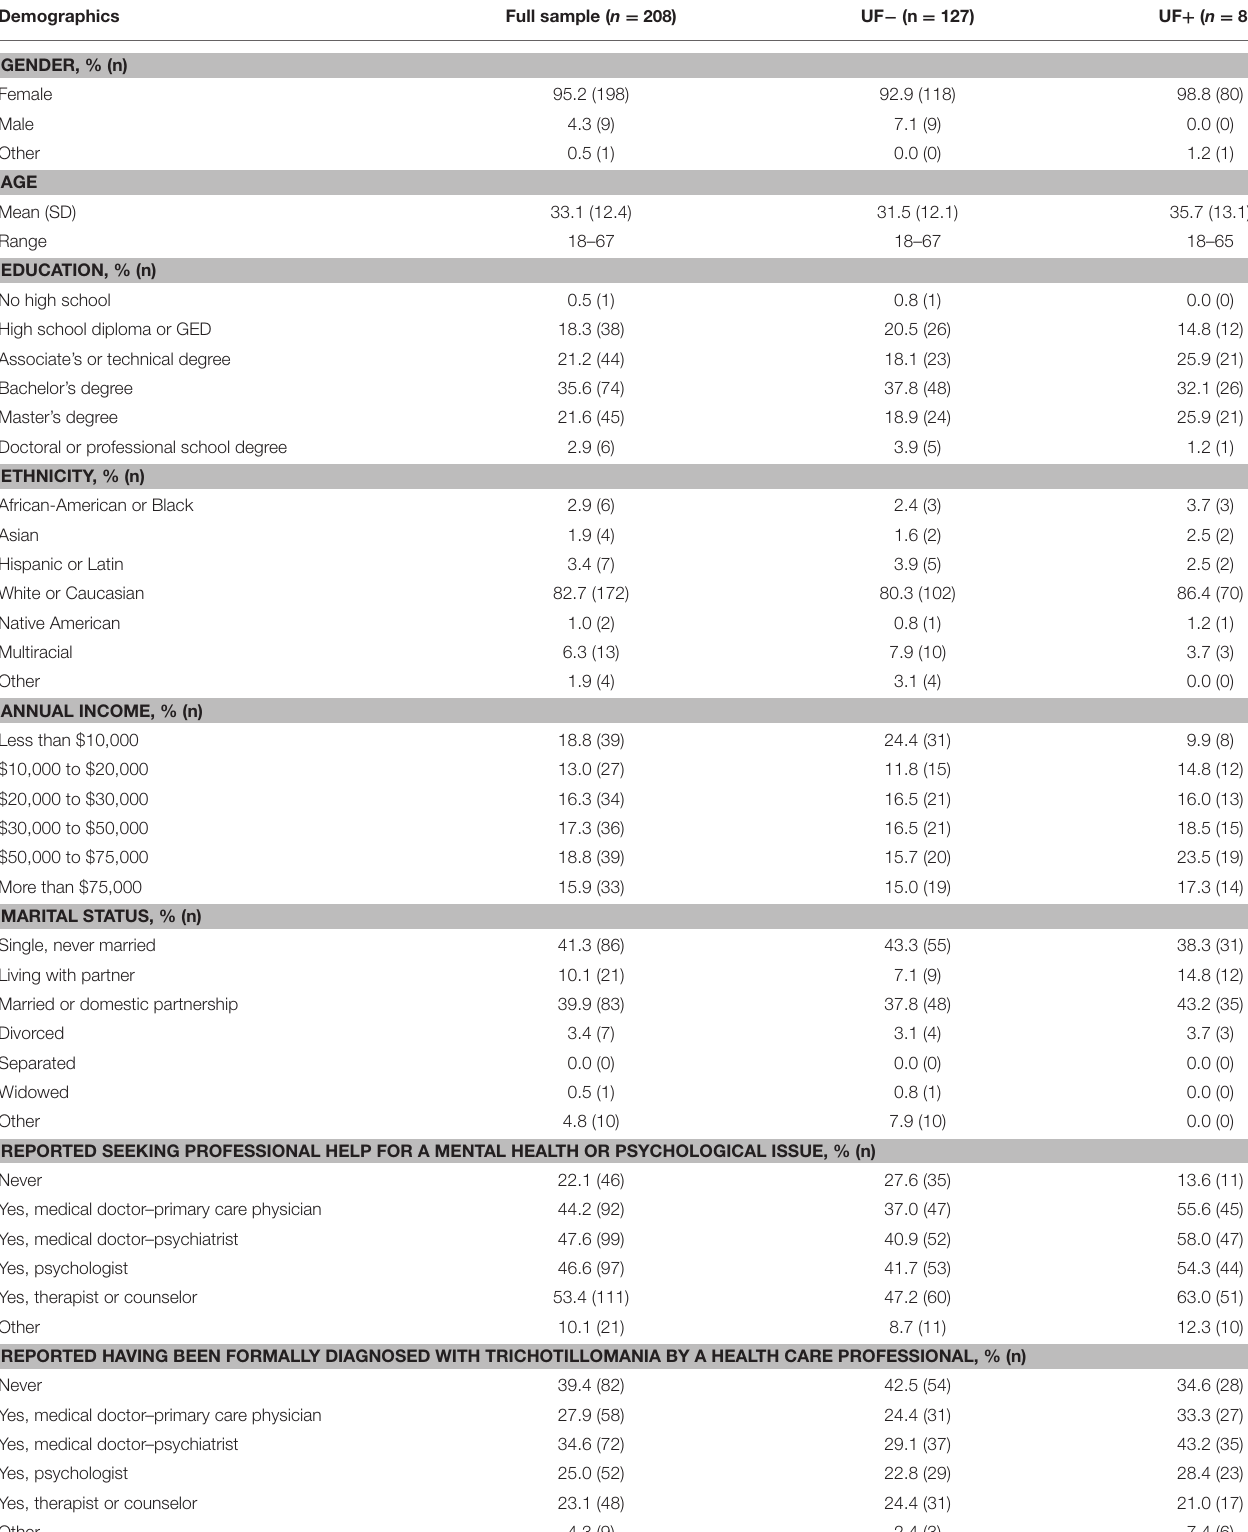
TABLE 1 | Demographics and behavioral characteristics of the full participant sample, as well as of the Unhealthy Food Negative (UF-) subgroup and the Unhealthy Food Positive (UF + ) subgroup.